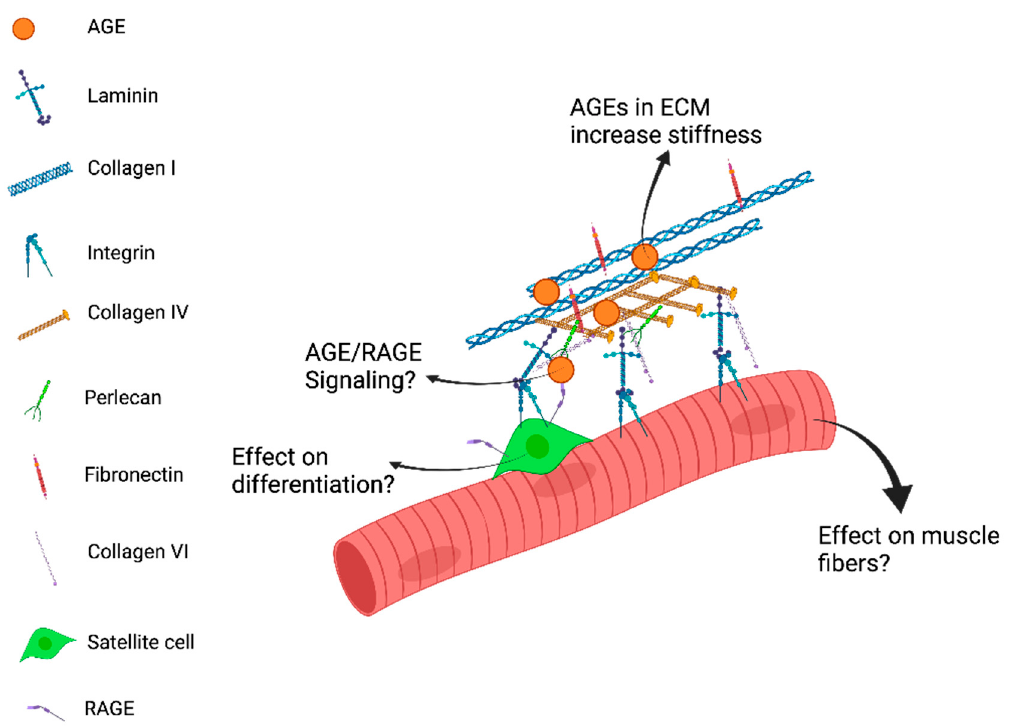
Figure 1. Advanced glycation end-products (AGEs) in skeletal muscle are associated with receptor for advanced glycation end-products (RAGE) activation and have been associated with muscle aging. RAGE plays a normal role in supporting adult myogenesis; however, when there is a pathological increase in RAGE activation due to AGEs, muscle wasting, increased muscular inflammation, and deleterious satellite cell signaling occurs. What remains unclear is whether effects from AGEs are due to soluble factors that activate RAGE signaling or from extracellular matrix cross-links that signal via RAGE as well. This figure proposes answered questions due to AGE cross-linking in muscle